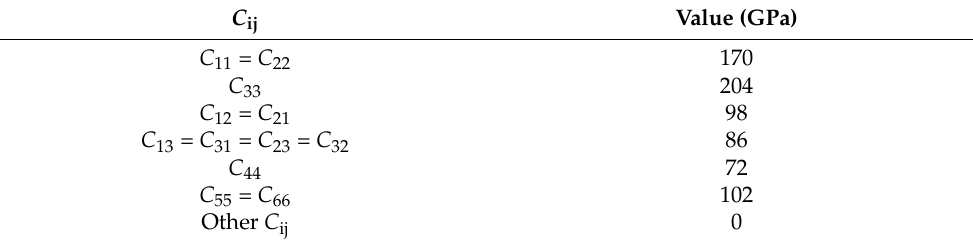
Table 5. α transverse isotropic elastic tensor parameter of the phase [40]. C ij